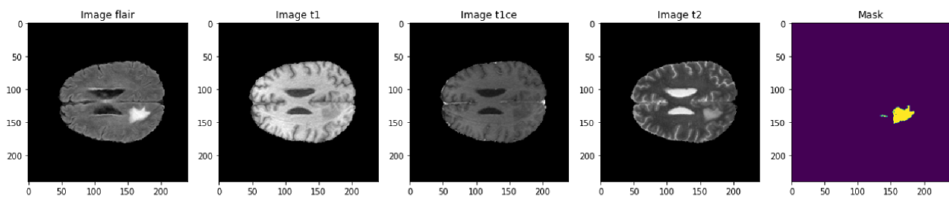
Figure 8. Visualize image with mask of a positive brain tumor.